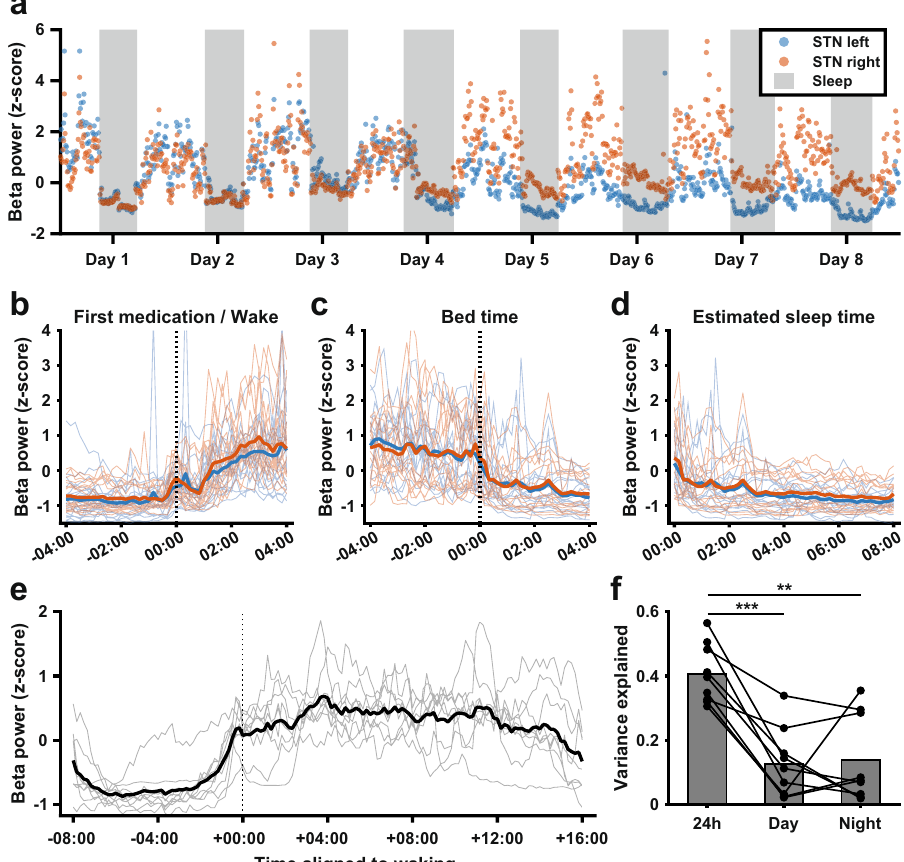
Fig. 2 Diurnal variations in beta power are largely accounted for by transitions between sleeping and waking periods. a Normalized beta power in the left and right STN (blue and orange, respectively) of one patient over a period of 8 days during which the patient recorded when they went to bed and when they rose in the morning. Gray areas represent the time the patient was in bed for the night. b Normalized beta power as in a for the full 21-day recording period, aligned to the time of waking. Blue and orange lines represent the mean for the left and right STN respectively, while thin blue and orange lines represent the corresponding individual time series. c Normalized beta power as in a for the full 21-day recording period, aligned to the time of going to bed. Blue and orange thick lines represent the mean for the left and right STN respectively, while thin blue and orange lines represent the corresponding individual time series. d Normalized beta power as in a for the full 21-day recording period, between going to bed and waking up. Blue and orange thick lines represent the mean for the left and right STN respectively, while thin blue and orange lines represent the corresponding individual time series. e Average beta power aligned to estimated average wake-up time for all STN time series in the data set (gray lines, n = 9) and mean across all-time series (thick black line). f Variance explained by time of day across the whole 24 h cycle vs. during the day or night alone. Full 24 h: 0.41 ± 0.092; Day only: 0.13 ± 0.11, Wilcoxon ’ s signed-rank = 45, p = 0.039 vs 24 h; Night only: 0.14 ± 0.13, Wilcoxon ’ s signed-rank = 43, p = 0.012 vs. 24 h; n = 9 STN time